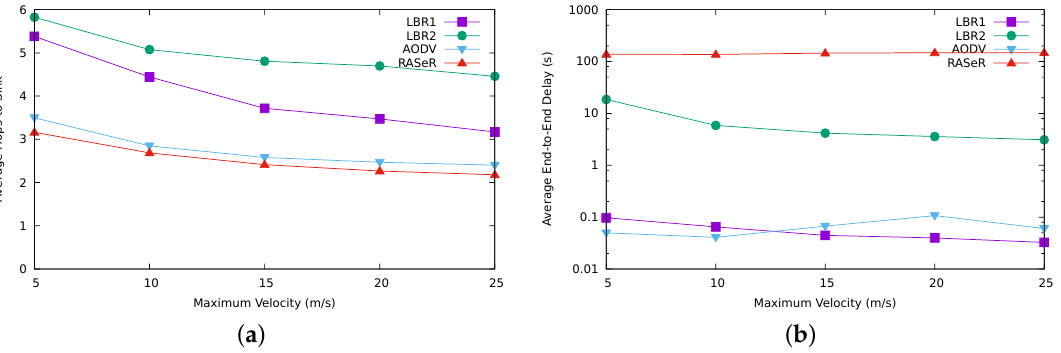
Figure 8. End-to-end delay results about resilience to mobility. Results obtained for 64 nodes. Note the logarithmic scale on the y axis for Figure 8b. ( a ) Hops to reach the sink (average); ( b ) End-to-end delay